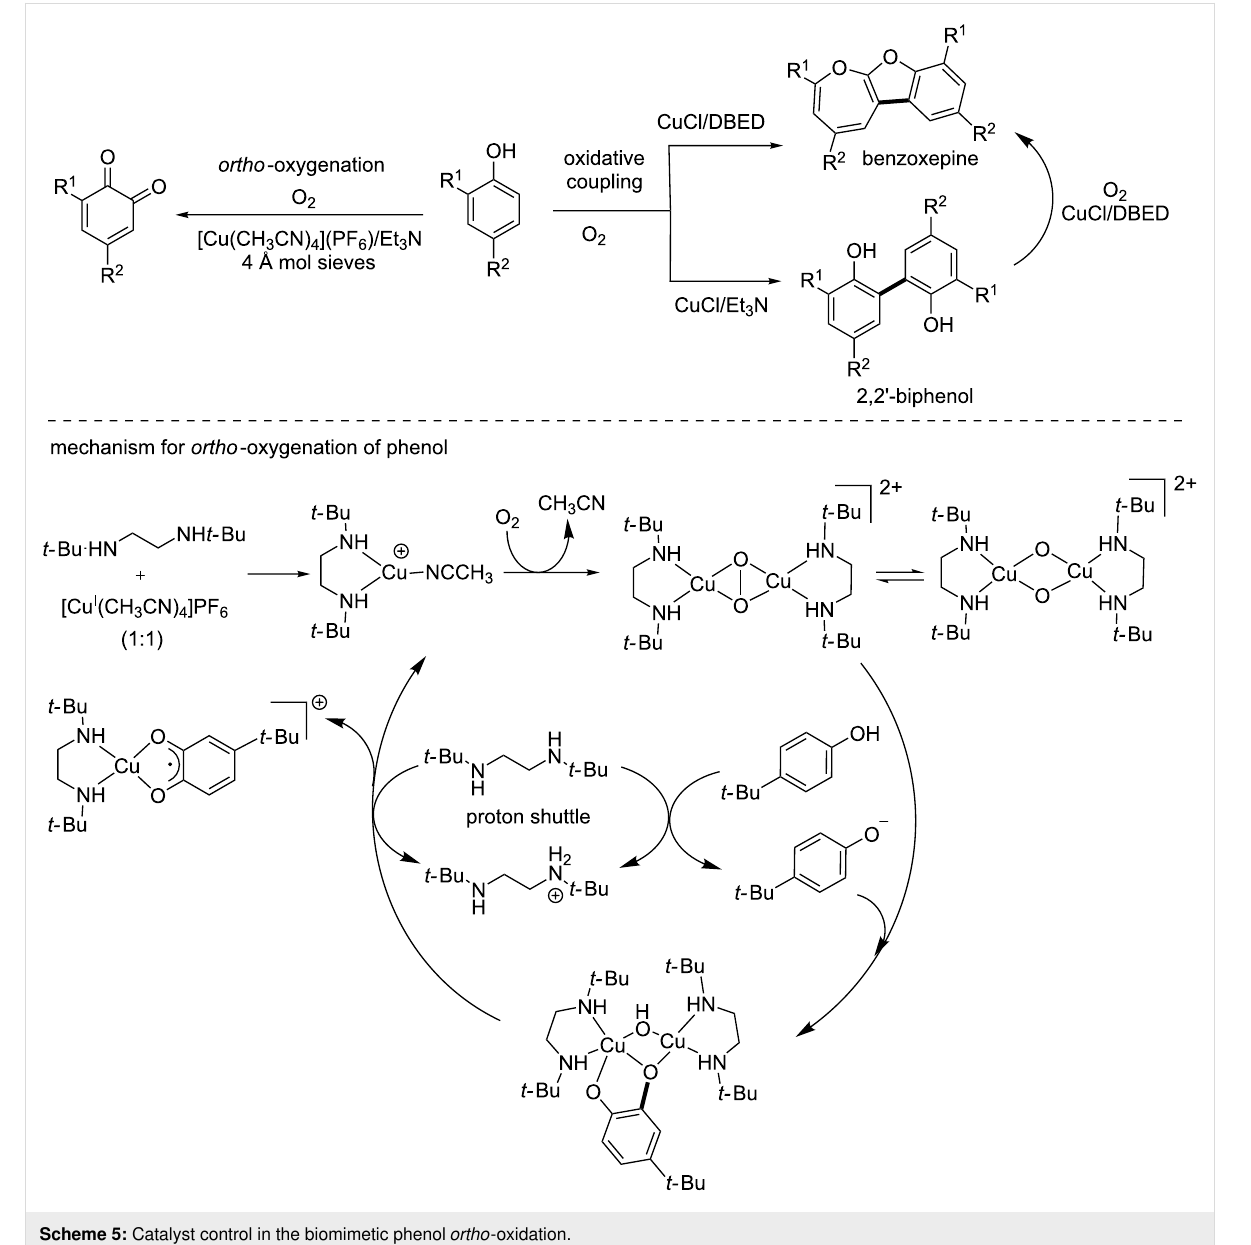
Scheme 5: Catalyst control in the biomimetic phenol ortho